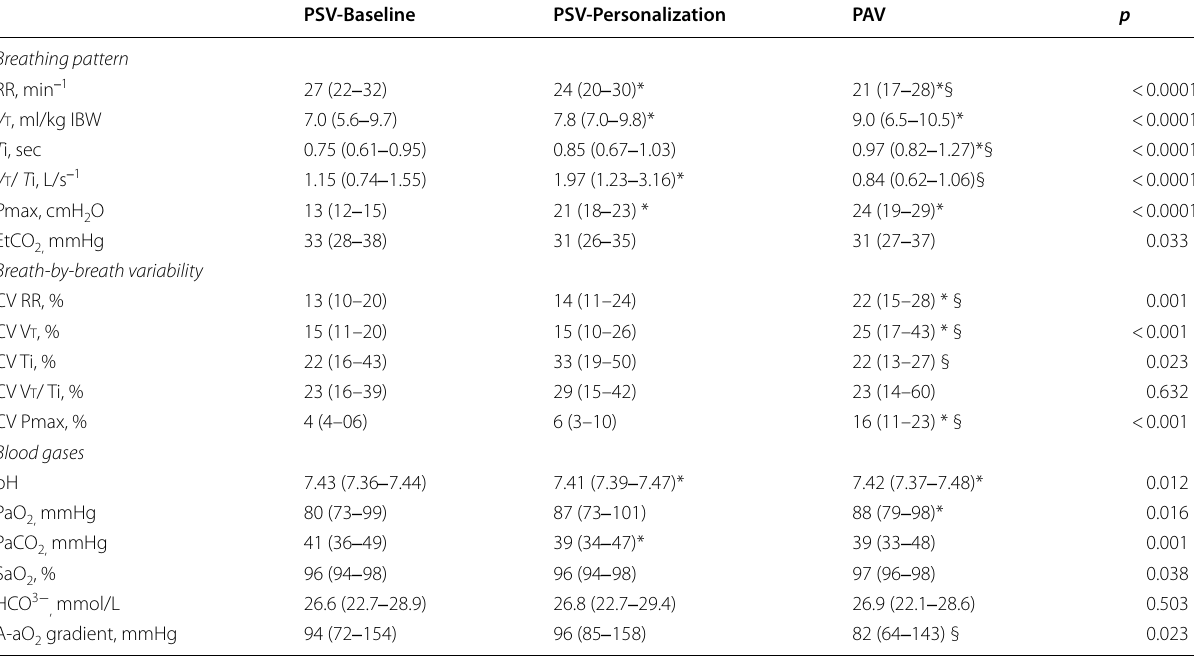
Table 3 Breathing pattern and blood gases at baseline (PSV‑Baseline), after personalization of ventilator settings (PSV‑Personalization) and with proportional assist ventilation (PAV)